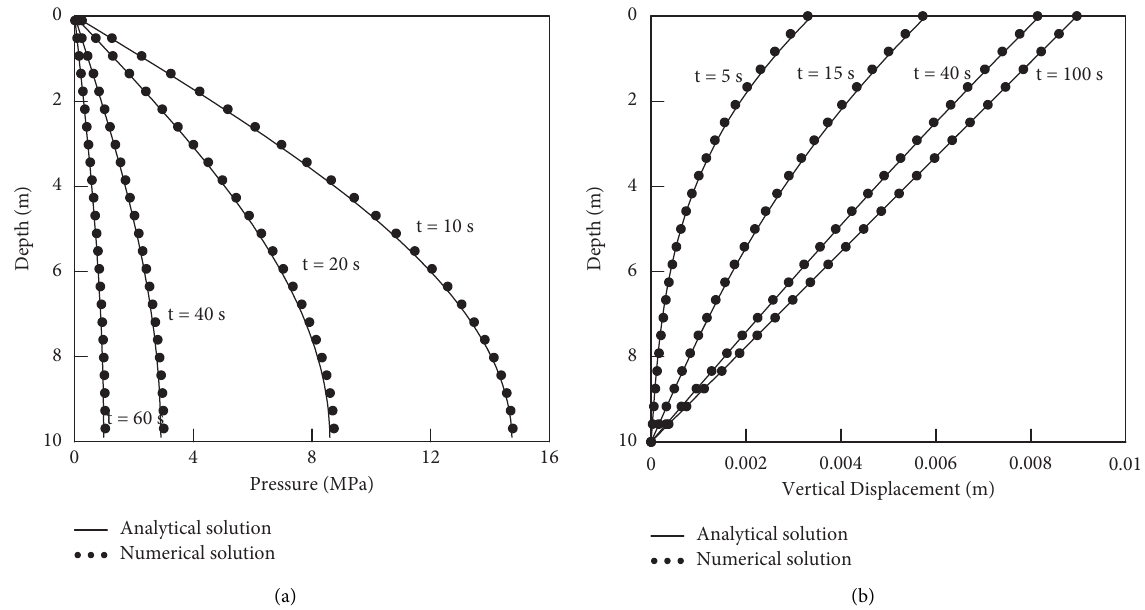
Figure 7: Comparisons of (a) vertical displacement and (b) pore pressure distribution between analytical solution and numerical solution in Terzaghi’s problem.